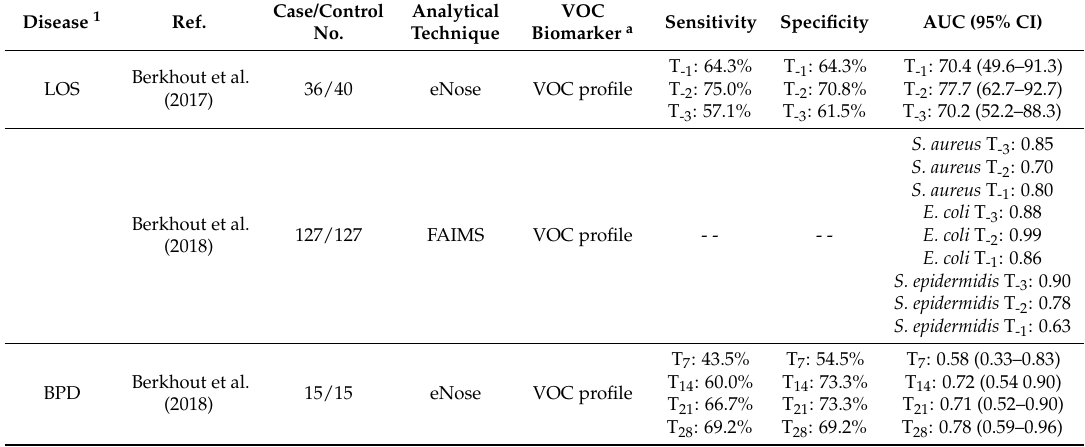
Table 4. Overview of studies on fecal VOC analysis in extra-intestinal diseases. Disease